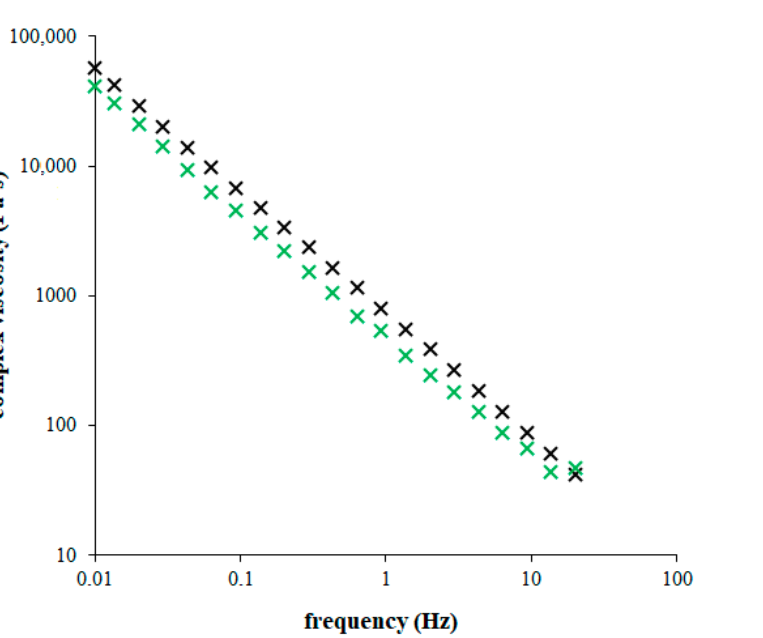
Figure 7. Complex viscosity measured for pure agarose hydrogel (black) and hydrogel enriched by chitosan (1 mg g − 1 ; green). Measurement was realized in linear viscoelastic region (strain 0.1 %).